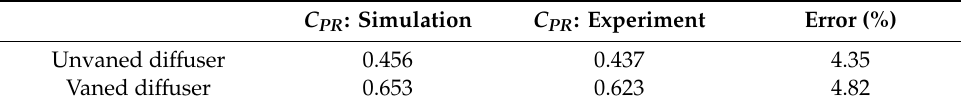
Table 3. Comparison of C PR between simulation and experiment.